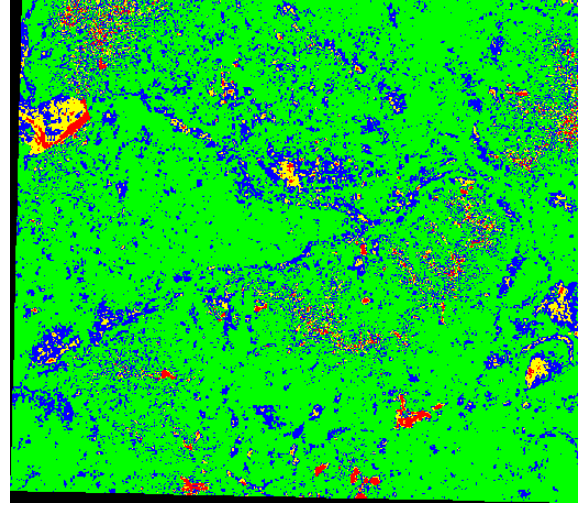
Figure 9. Color mapping of the differential DEM between the ZY-3 DEM and SRTM DEM according to the standard deviation